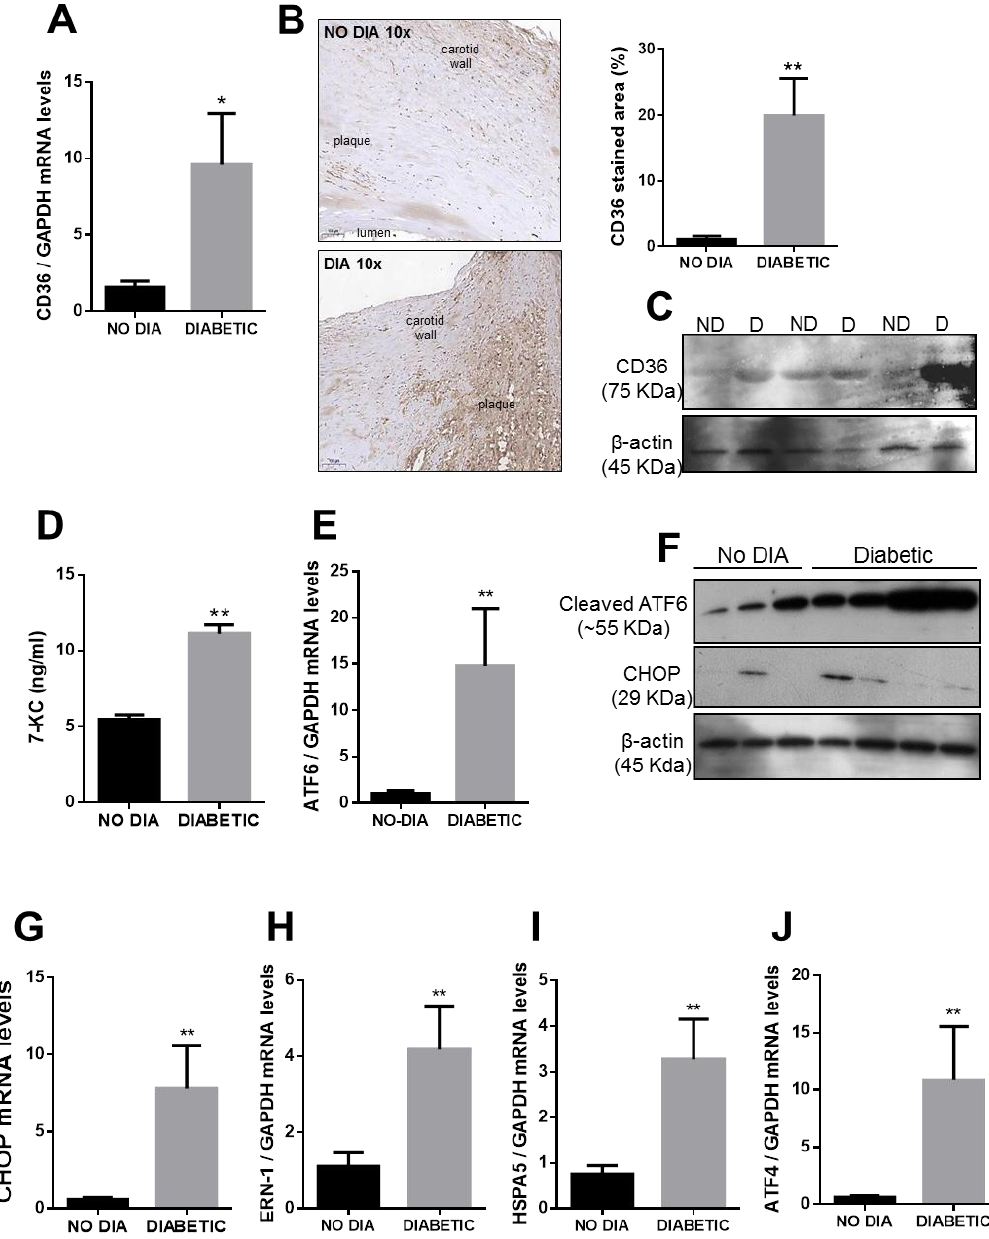
Figure 6. CD36 and ER stress markers expression in carotid plaques from subjects with and without diabetes. ( A , E , G – J ) the mRNA levels of CD36 and endoplasmic reticulum (ER) stress markers were determined in sections of carotids plaques from subjects with and without diabetes by qPCR analysis ( n = 15). ( B ) Immunostaining of CD36 in para ffi n sections of carotid plaques ( n = 5). ( C ) Representative blot of CD36 in protein lysates from carotid plaques. ( D ) Histogram showing circulating levels of 7-KC in plasma from subjects with diabetes ( n = 18) and subjects without diabetes ( n = 18) determined by LC-MS / MS. ( F ) Representative blots of ATF6 and CHOP in protein lysates from carotid plaques. Results are expressed as mean ± SEM. * p < 0.05 vs. Subjects without diabetes (NO DIA). ** p < 0.01 vs. NO